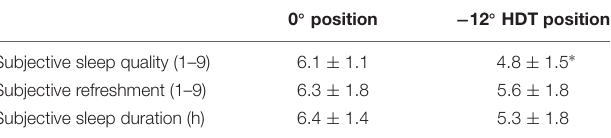
TABLE 4 | Subjective sleep